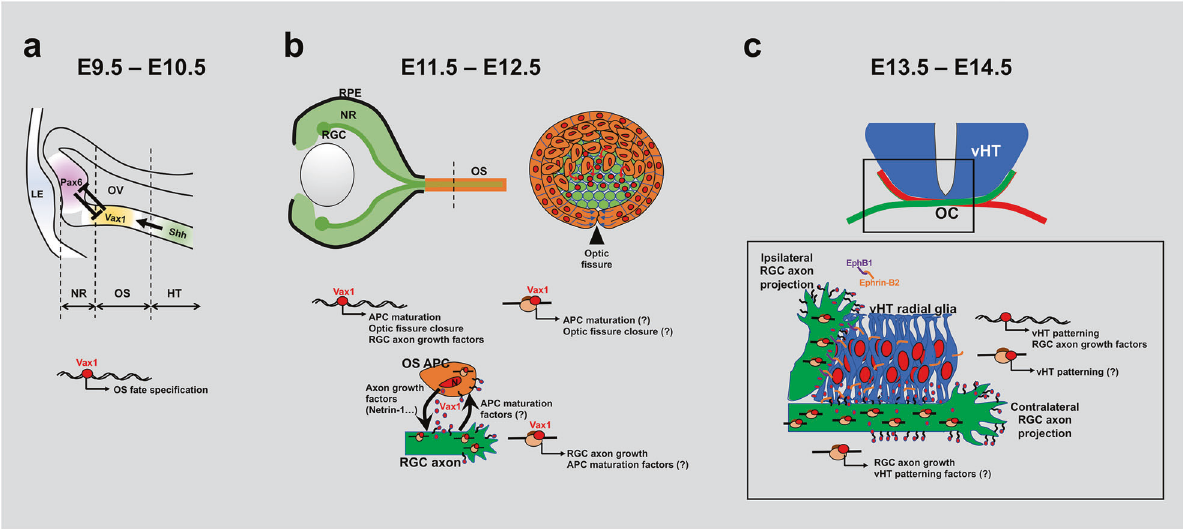
Fig. 9 Schematic diagram depicting the pleiotropic roles of Vax1 in mouse optic nerve development. a Vax1 is expressed in the proximal optic vesicle (OV) downstream of the Shh signal, which comes from the ventral midline and speci fi es OS fate by suppressing the expression of retinal determinants, including Pax6 15 , between E9.5 and E10.5. b This event is followed by invagination of the OV that forms a double-layer optic cup of neural retina (NR) and RPE in the distal OV between E11.5 and E12.5. The fi ssures in the OS (arrowhead) and the optic cup are also closed as a result of invagination. Optic fi ssure closure was impaired in Vax − / − mice but delayed in Vax1 AA/AA mice, which express secretion- defective and transcription-competent Vax1 AA mutants (Fig. 3b). These results suggest that Vax1 regulates fi ssure closure not only through the expression of target genes in the OS cell nucleus but also via secretion. The secreted Vax1 not only penetrates neighboring RGC axons but can also reenter OS APCs. Autocrine Vax1, in turn, might induce the expression of genes that regulate APC maturation and/or fi ssure closure, as